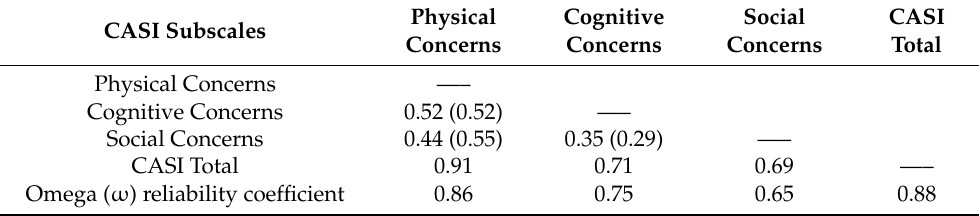
Table 2. Correlations between the subscales and between the factors (in parenthesis) of the CASI ( N =